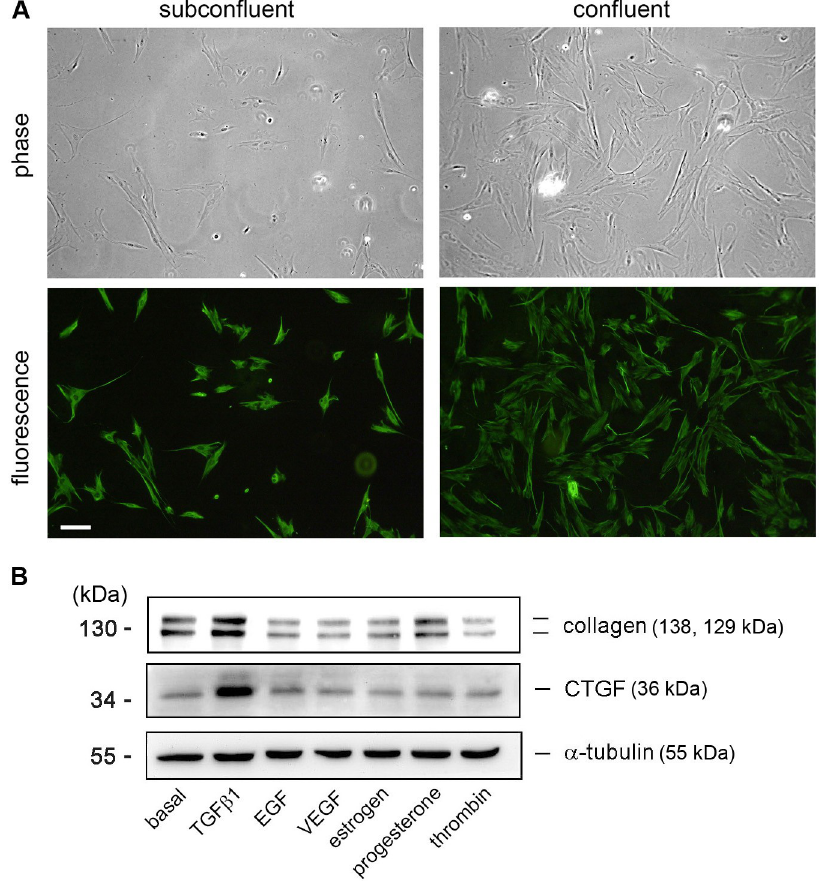
Fig 1. Characterization of prepared HESCs and effects of mediators on collagen and CTGF expression in HESCs. (A) HESCs were isolated and prepared as described in the Materials and Methods. Cell morphology was analyzed through phase-contrast microscopy (upper panels) and the fibroblast identity was determined through immunofluorescence microscopy (lower panels) (n = 3). (B) Effect of mediators on collagen and CTGF expression. Cells were treated with mediators for 16 h. The concentration for each mediator was TGF β 1 (10 ng/ml), EGF and VEGF (50 ng/ml), estrogen (1 μ M), progesterone (2 μ M), and thrombin (2 U/ml). The protein expression was determined through Western blotting (n =